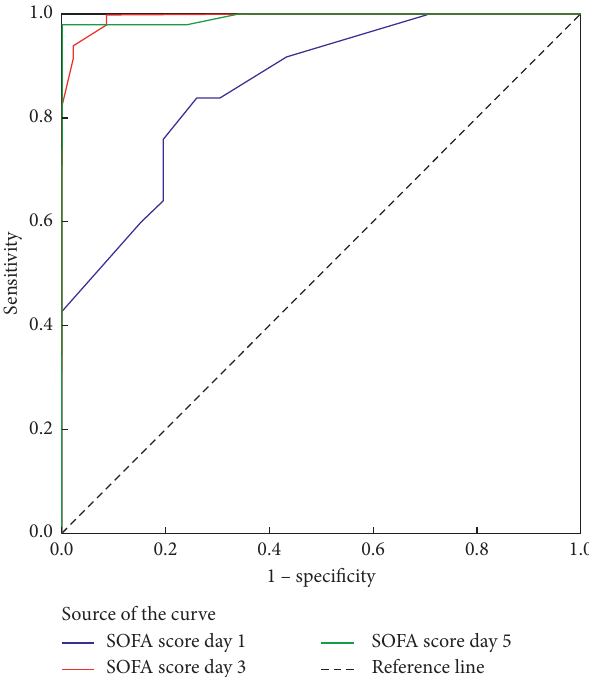
Figure 2: ROC of SOFA scores in differentiating mortality.